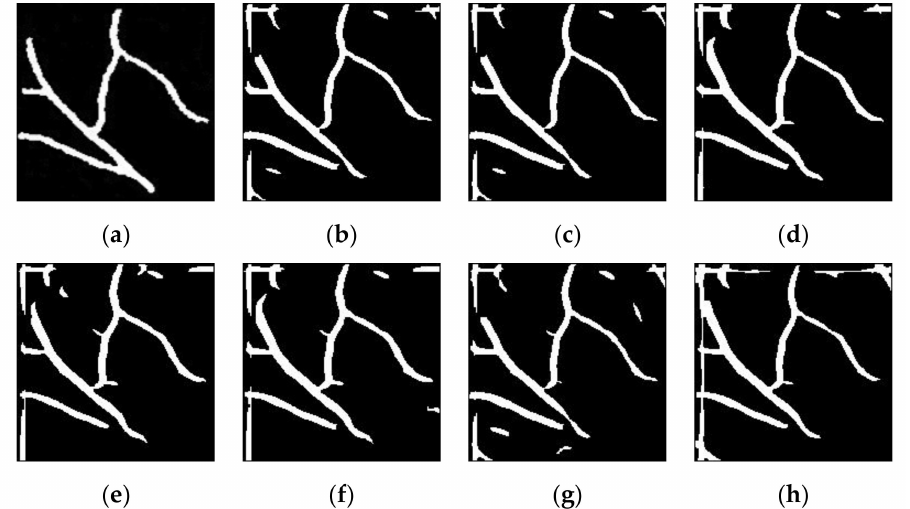
Figure 10. Sample results of vein detection for various image enhancement techniques on a self- acquisition database: ( a ) truth image; ( b ) improved weighted average fusion CLAHE + FAG(proposed); ( c ) weighted average fusion CLAHE + FAG(proposed); ( d ) FAG(proposed); ( e ) AGC; ( f ) FHH; ( g ) CLAHE; ( h ) without enhancement.